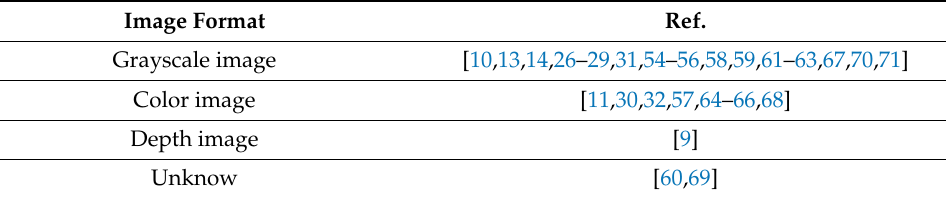
Table 10. The study of the distribution by image format in Figure 7b.